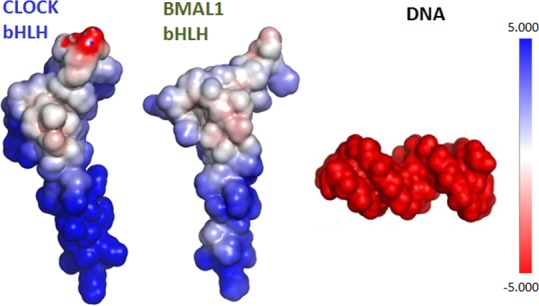
The electrostatic surface potentials of the CbHLH+BbHLH+DNA model.The electrostatic surface potentials for the bHLH domains of the CLOCK and BMAL1 proteins, and for the DNA molecule in the CbHLH+BbHLH+DNA model.